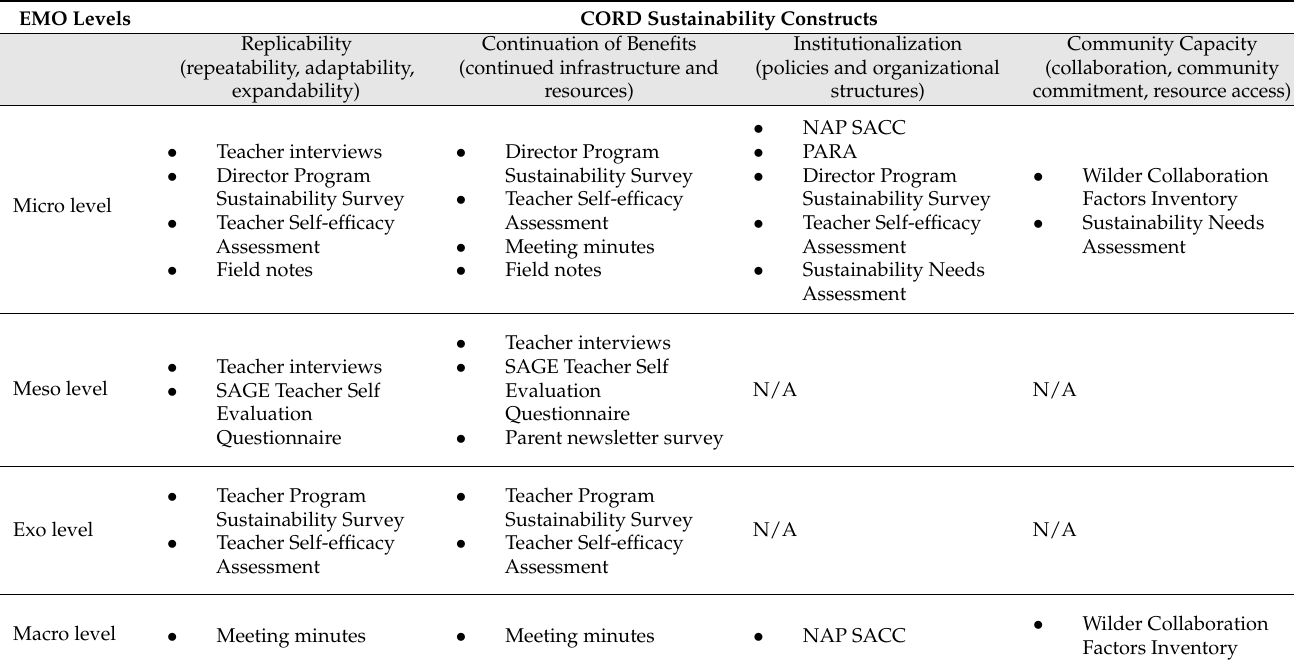
Table 1. Measures for Evaluating the SAP by Ecologic Model of Obesity (EMO) Level and Sustain- ability